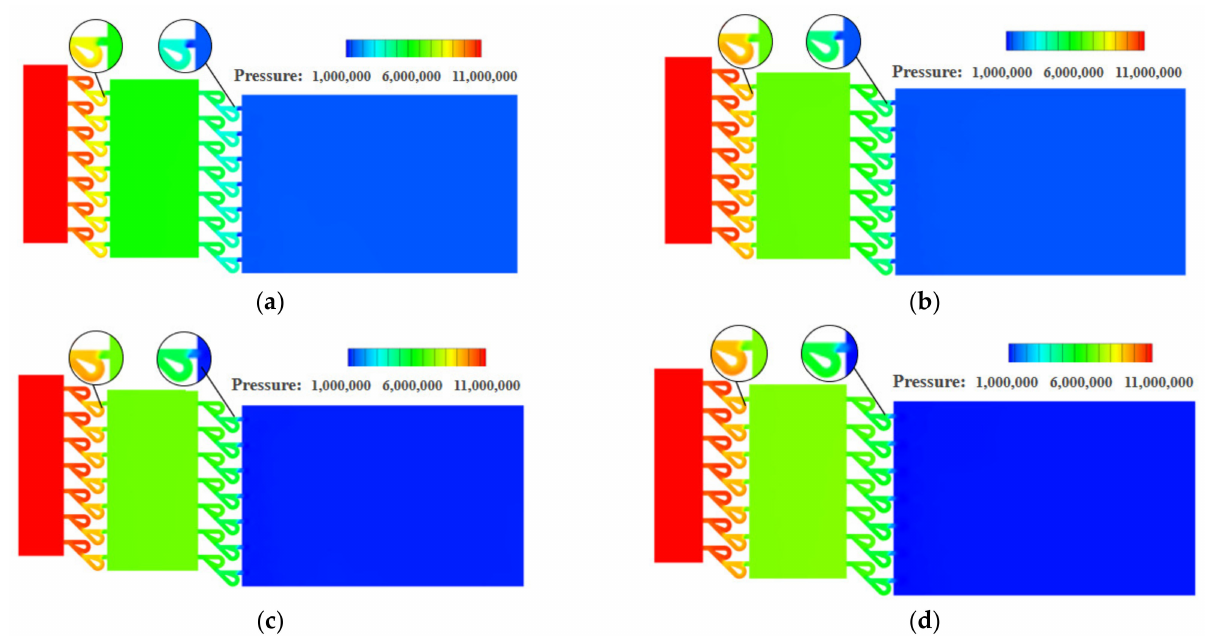
Figure 14. Pressure distribution on the symmetry plane for the two-stage Tesla-type orifice structure under different mass flow rates (Pressure in Pascal). ( a ) Q m = 0.02 kg s − 1 . ( b ) Q m = 0.1 kg s − 1